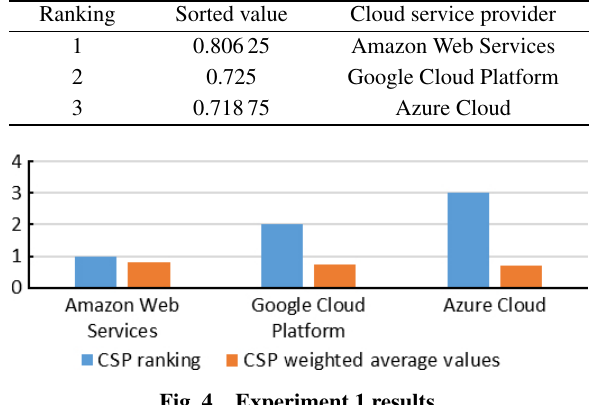
Table 16 Weighted average values and ranking in